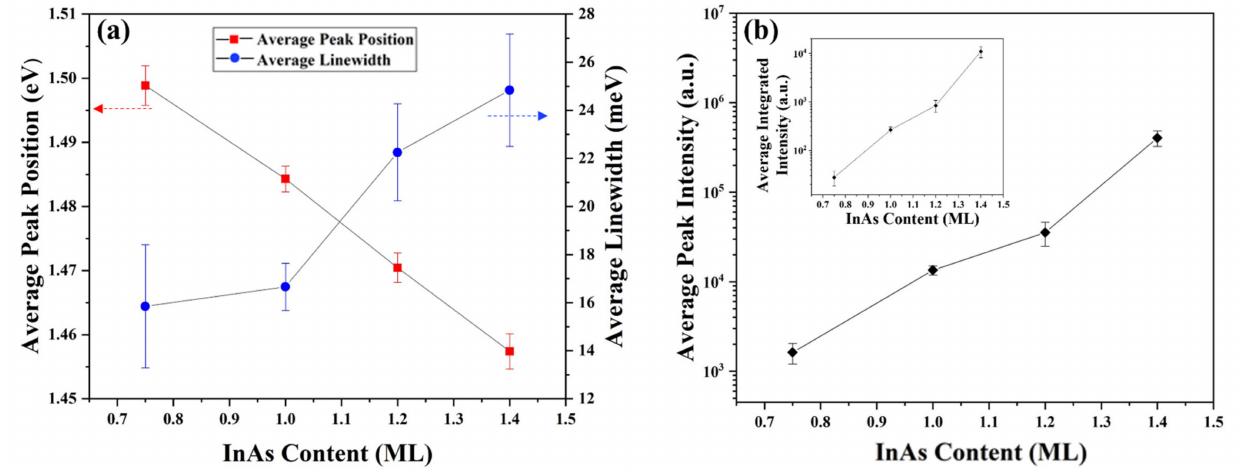
Figure 6. ( a ) Average peak position and linewidth of different InAs layers with a function of InAs content. ( b ) Average peak intensity and integrated intensity of different InAs layers with a function of InAs content. The statistical result is obtained from ten distinct excitation spots far away from each